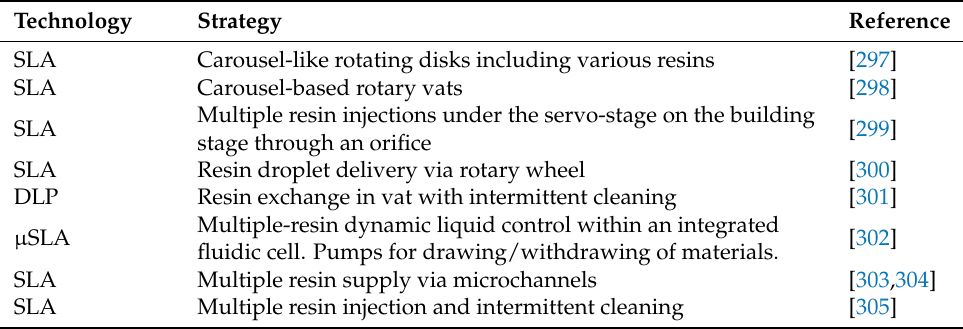
Table 5. Multi-material vat